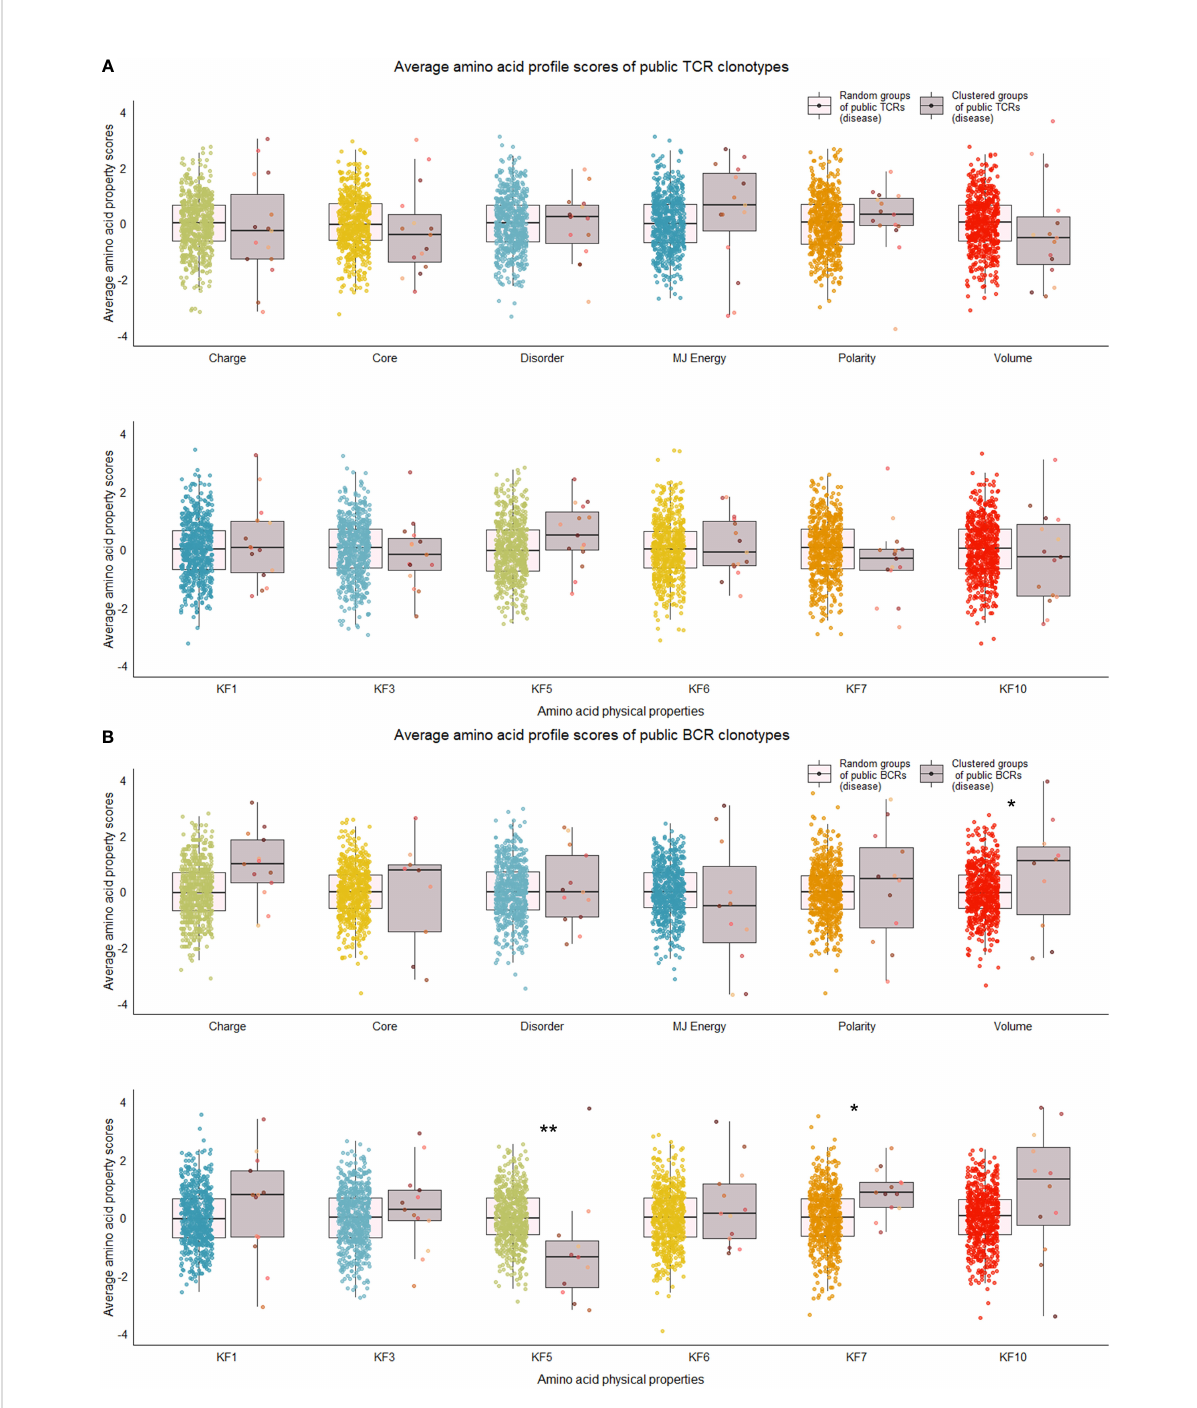
FIGURE 6 Distribution of average amino acid property scores for selected clusters of public BCR and TCR amino acid sequences compared to random groups of public BCR and TCR amino acid sequences from disease-associated immune repertoires. (A) Boxplots of scaled average amino acid physical property scores of TCR amino acid sequences from selected clusters (mauve colors) compared to those of randomly selected T cell clonotype groups (rainbow colors) of individuals with disease. (B) Boxplots of scaled average amino acid physical property scores of BCR amino acid sequences from selected clusters (mauve colors) compared to those of randomly selected B cell clonotype groups (rainbow colors) of individuals with disease. Dots represent averages of each cluster or random group. P -values are from Kolmogorov-Smirnov tests for difference of two distributions, i.e. averages of random groups of amino acid sequences and averages of clustered clonotype sequences. ** P -value< 0.005. * P -value< 0.05. KF kidera factors (KF1 helix/bend preference, KF3 extended structure preference, KF5 double-bend preference, KF6 partial speci fi c volume, KF7 fl at extended preference, KF10 surrounding